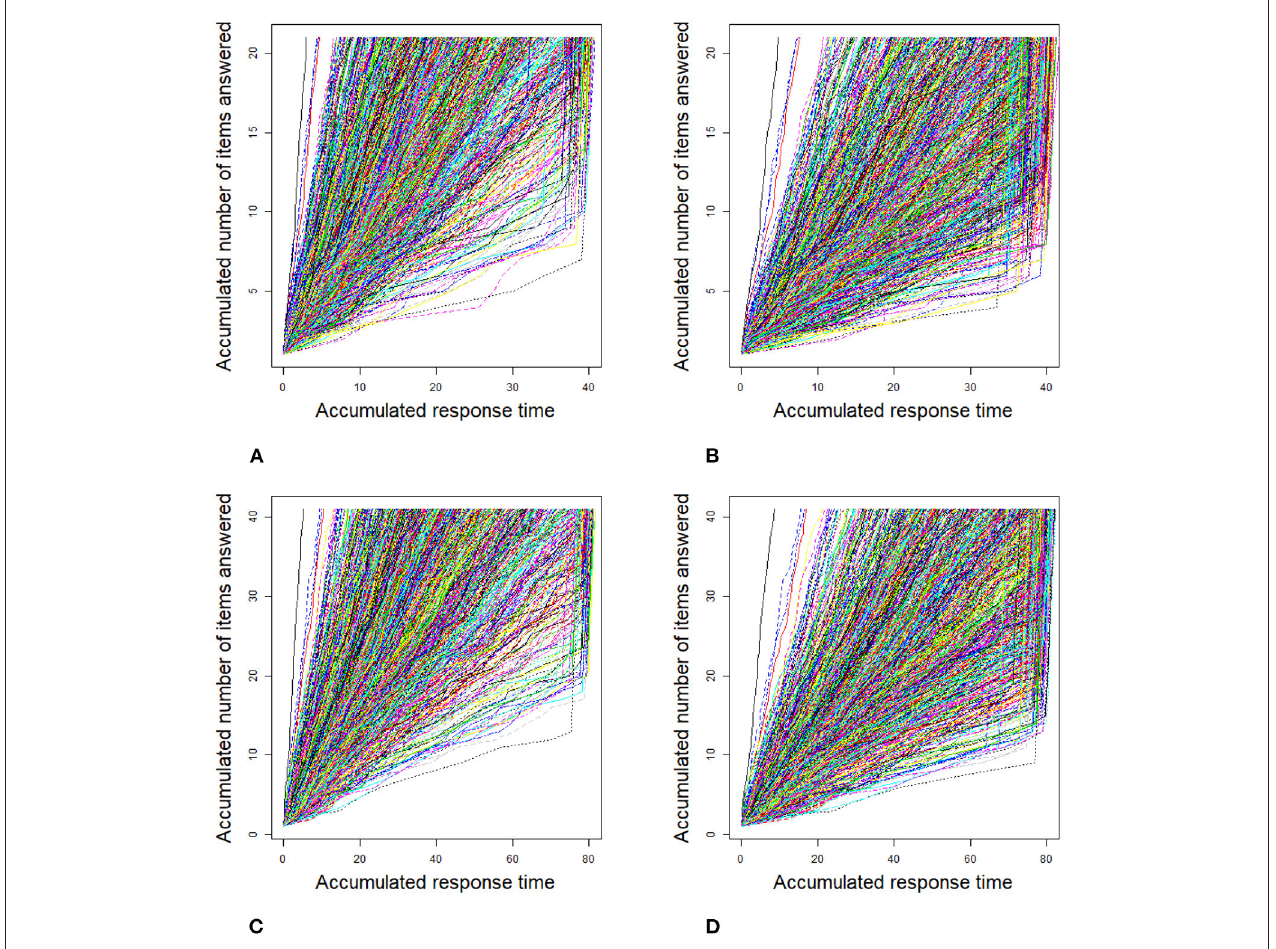
FIGURE 1 | Response time paths for 1,000 examinees at different speededness levels in the simulation study 1. (A) items 20 and low speededness, (B) items 20 and high speededness, (C) items 40 and low speededness, and (D) items 40 and high